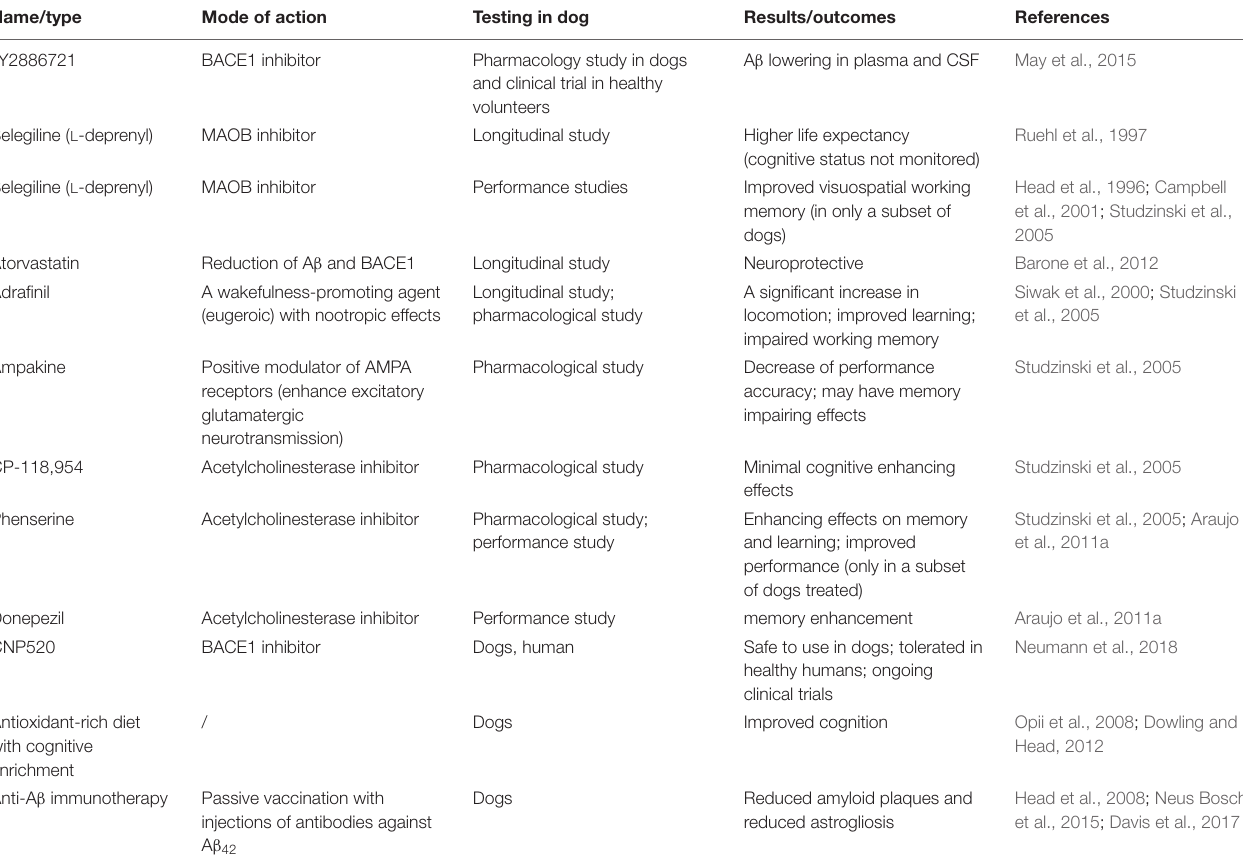
TABLE 3 | Pharmacological interventions tested in dogs with cognitive